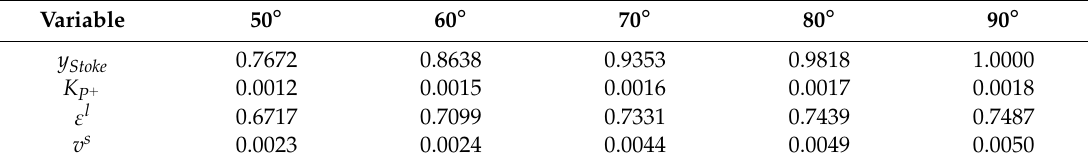
Table 2. Values of variables used in Equation (44) used to plot Figure for each angle θ .